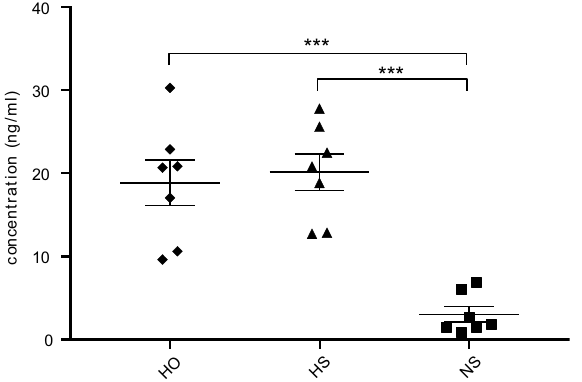
Figure 3. Concentration of hyaluronan in eluates. The concentration of hyaluronan in the eluates from the rats was measured after perfusion with physiological salt (NS), high osmolarity (HO) and high salt (HS) solution. Perfusing with HS or HO eluted similar amounts of hyaluronan, while NS eluted lower amounts. . ***P < 0.001, error bars represent SEM.